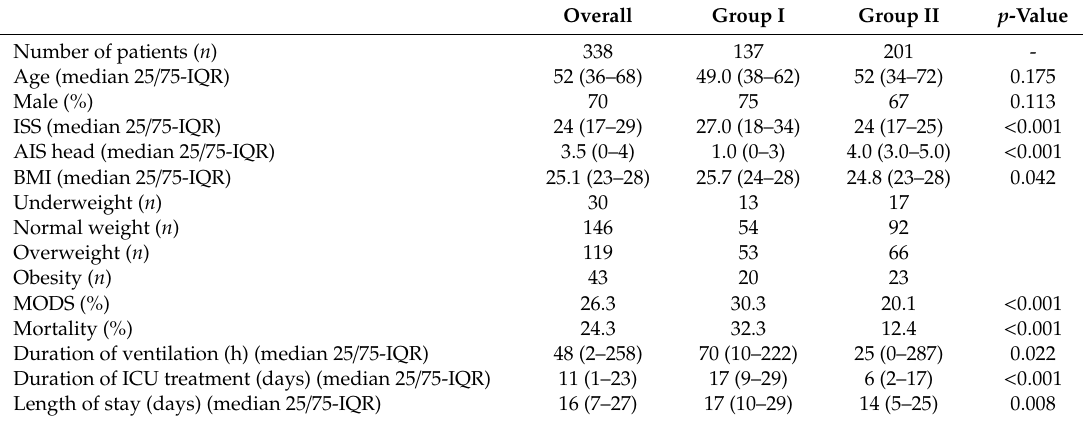
Table 1. Demographic overview according to the presence of severe chest